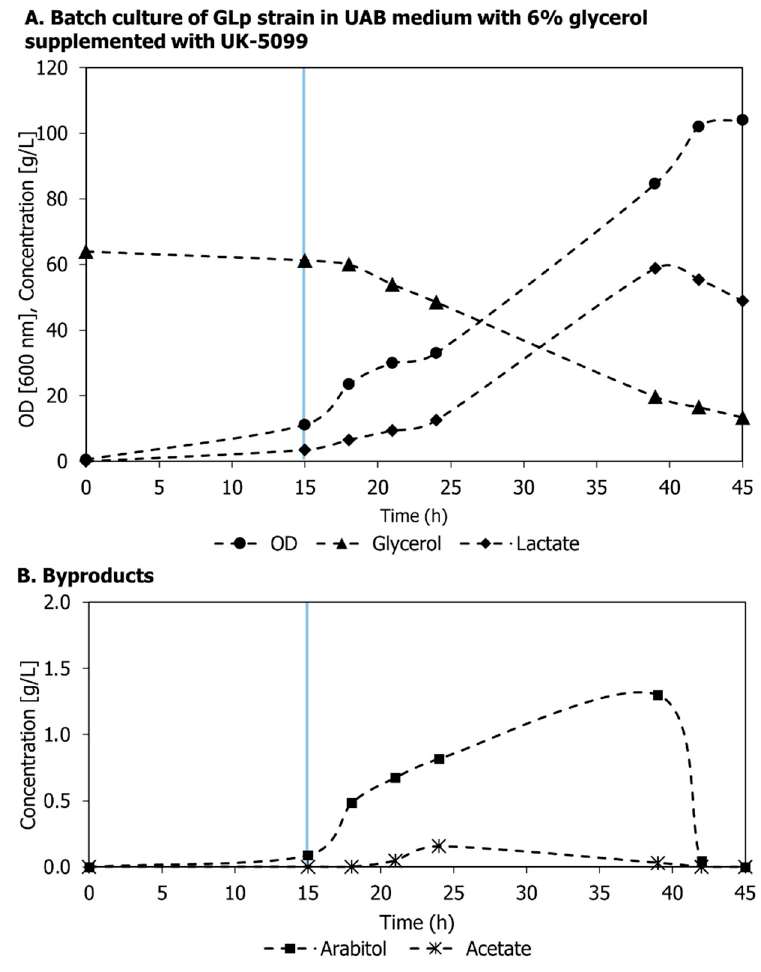
Figure 3. Cultivation profile of the GLp strain in 6% ( v / v ) glycerol supplemented with the Mpc inhibitor UK-5099 under aerobiosis in a 1.3 L bioreactor: ( A ) growth curve (circle), glycerol consumption (triangle), and lactic acid production (diamond); ( B ) arabitol (square) and acetate (asterisk) represented less than 1.5 g L − 1 . Experiments were carried out in biological duplicates. The blue line indicates the time of supplementation with UK-5099.